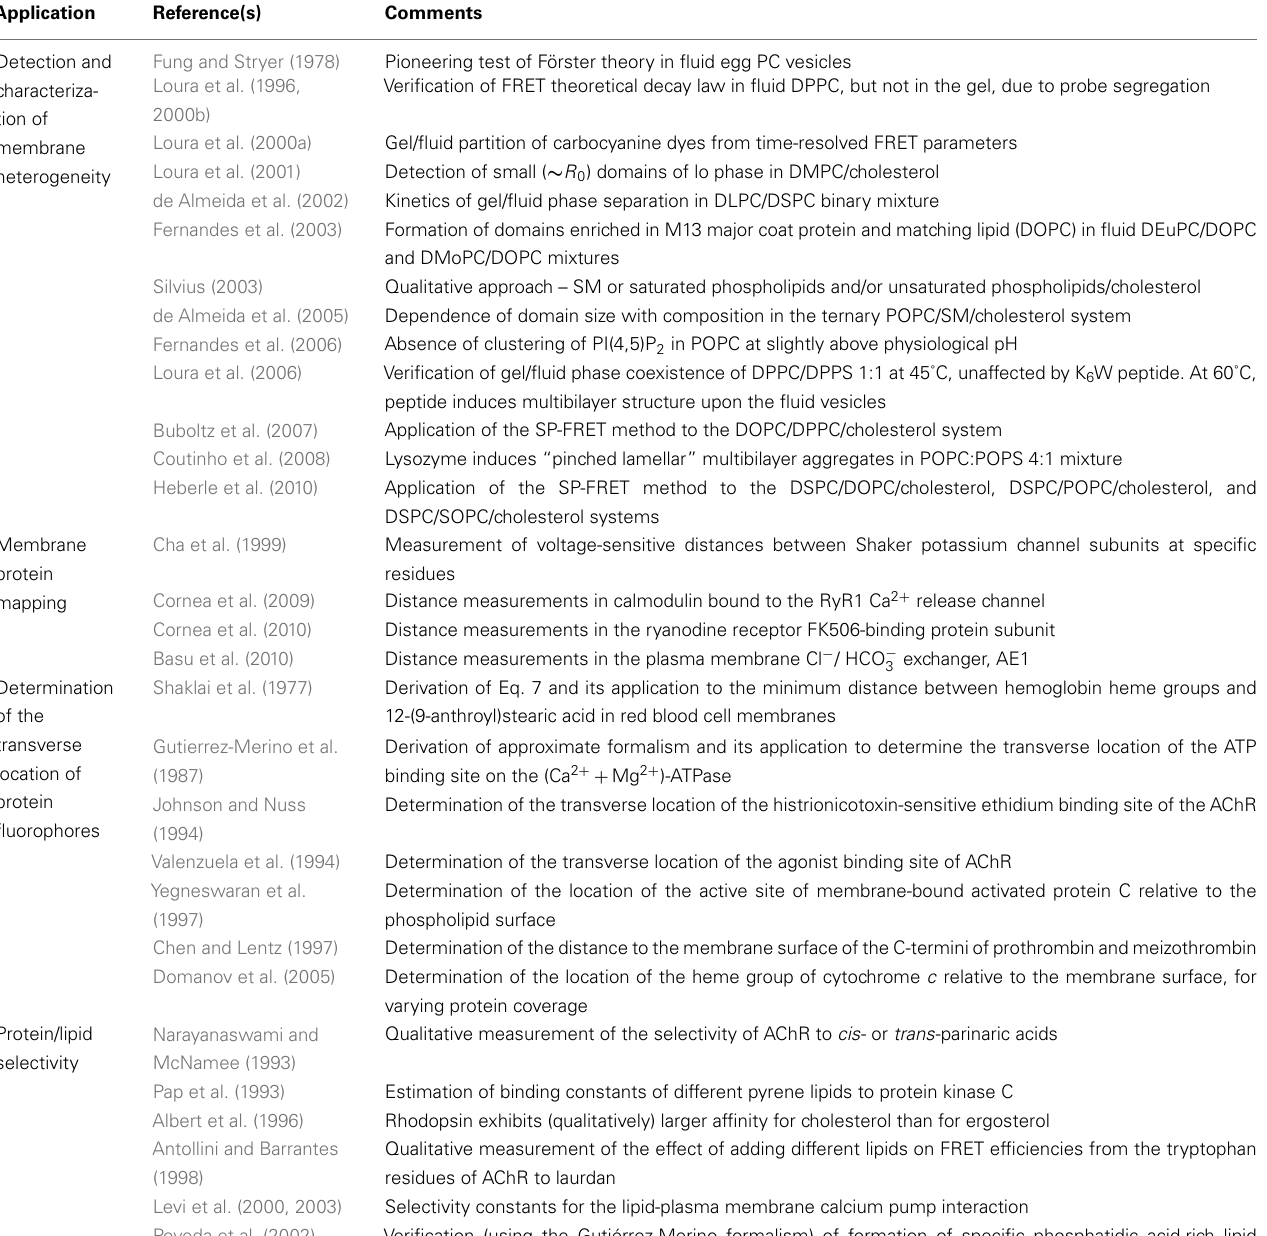
Table 1 | Selected examples of FRET membrane